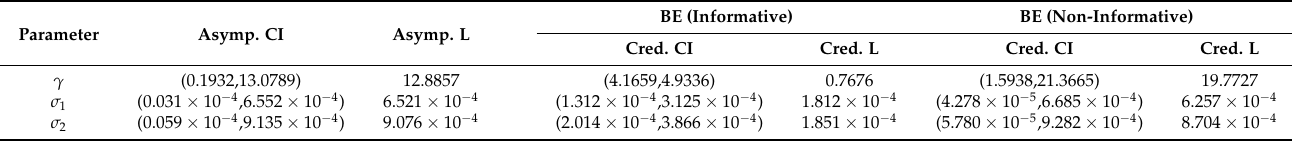
Table 4. 95% CIs with their lengths of the parameters γ , σ 1 and σ 2 for application 1.